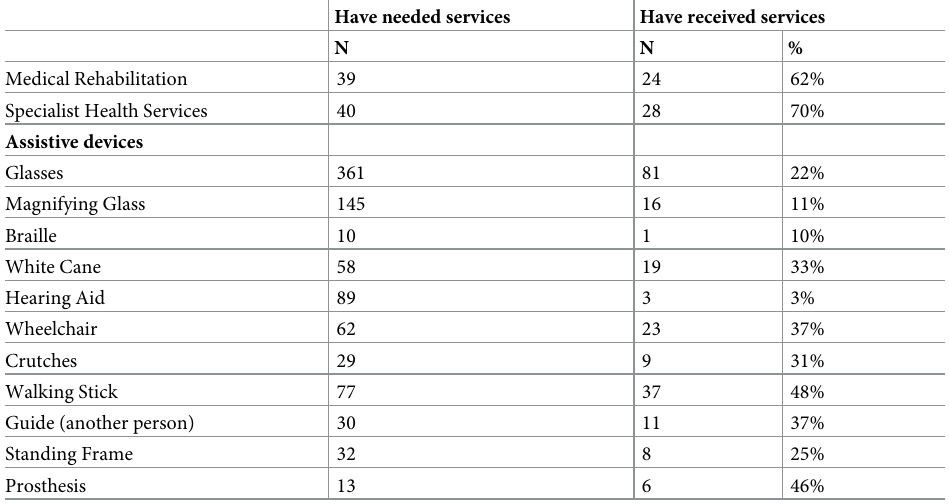
Table 5. Awareness and access to rehabilitation services among people with disabilities. Have needed